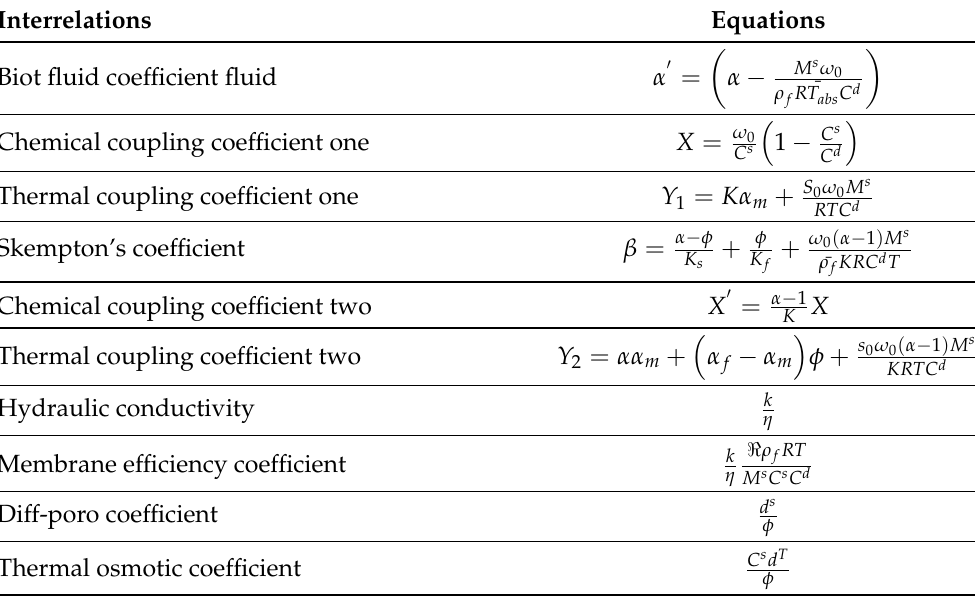
Table A2. List of Coefficient Variables Constructed in CSMP++ Using the